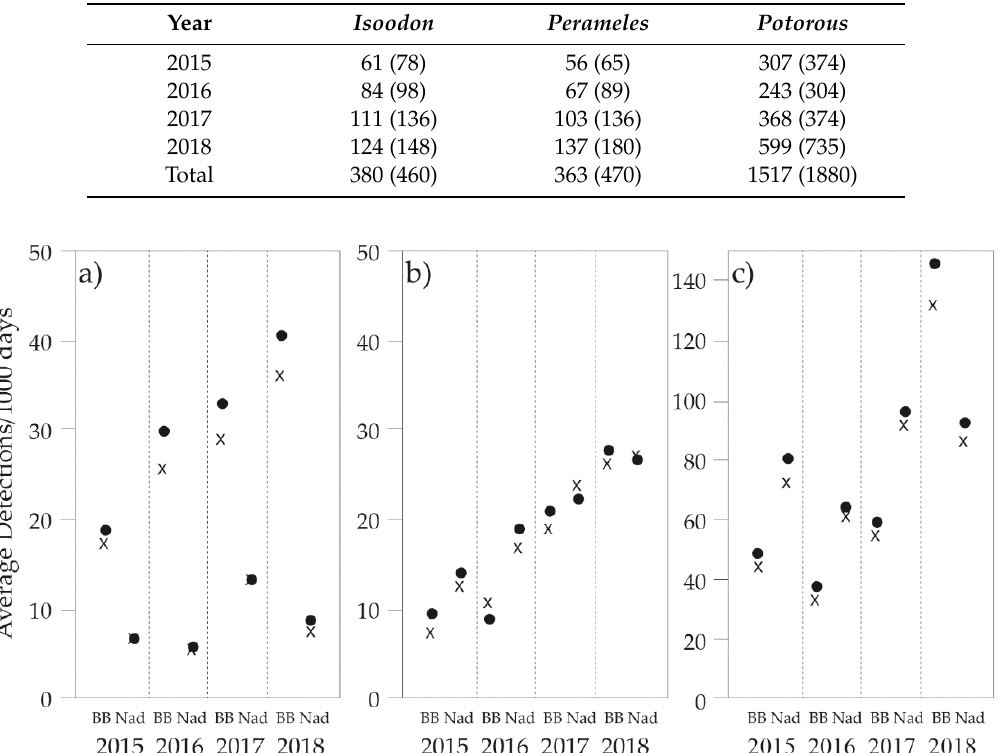
Figure 4. Average number of detections per thousand days for ( a ) Isoodon obesulus , ( b ) Perameles nasuta , and ( c ) Potorous tridactylus based on survey periods of 30-days ( ● ) and 40-days (x) in Ben Boyd (BB) National Park and Nadgee (Nad) Nature Reserve.